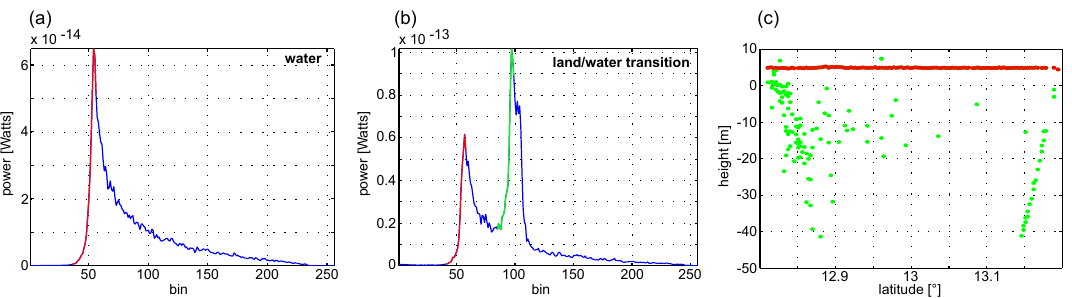
Figure 5. ( a ) An unscaled waveform over water and ( b ) an unscaled waveform at the land-water transition. The “best” sub-waveform is marked in red and the other sub-waveforms are marked in green. Plot ( c ) shows surface heights obtained from all sub-waveforms (green) and the “best” sub-waveform (red) of a CryoSat-2 track passing over the Lake Tonle